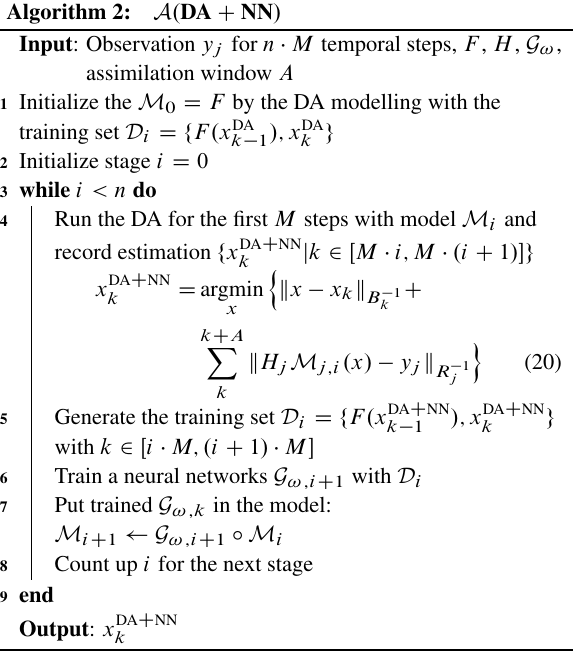
Algorithm 2: A . DA